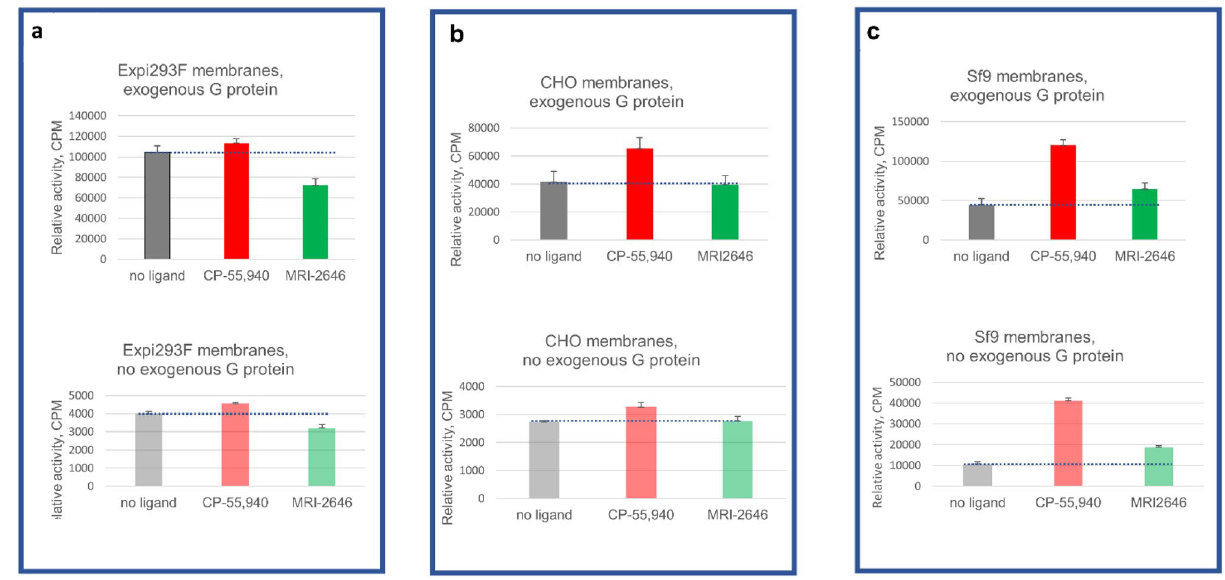
Figure 5. GEF analysis of three membrane preparations with or without supplementation with exogenous G protein. ( a ) Expi293F membranes; ( b ) CHO membranes; ( c ) Sf9 membranes. Bars represent an average of four independent measurements (n = 4). Dotted lines represent the rates of activation of G protein in the absence of a